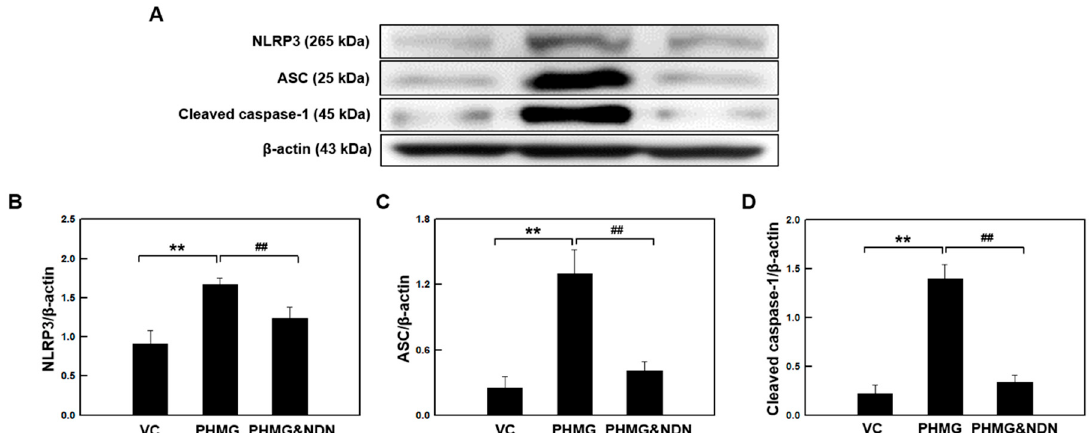
Figure 6. Effect of NDN on the expression of the NLRP3 inflammasome of mice. The levels of NLRP3, ASC, and cleaved caspase-1 expressions in the lung tissues were evaluated by western blotting ( A – D ). The blots were analyzed by densitometry and normalized to β -actin. Data are presented as the means ± SD ( n = 6/group). ** p < 0.01 vs. VC group, ## p < 0.01 vs. PHMG group.